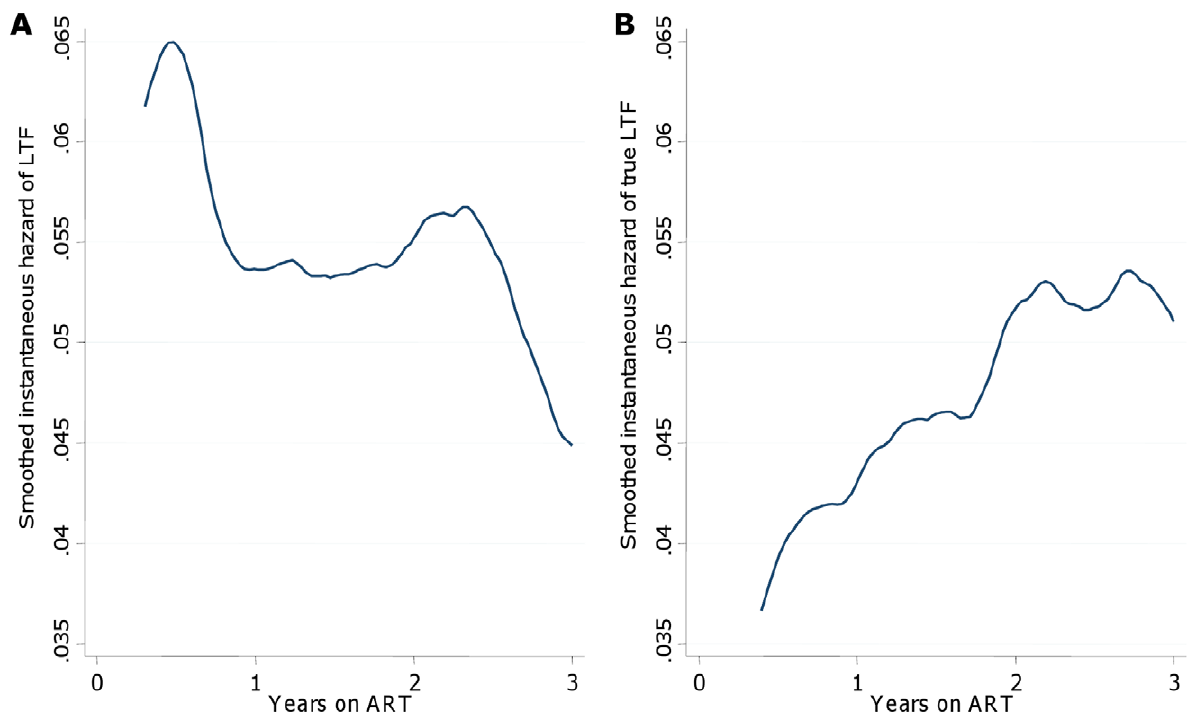
Figure 3. Smoothed hazard of loss to follow-up before and after ascertainment of vital status. Smoothed hazard estimates for loss to follow-up (LTF) before (A) and after (B) correction for mortality. Before ascertainment of vital status the hazard of LTF decreased over time on ART; after correcting LTF for mortality, the hazard of true LTF increased with time on ART.